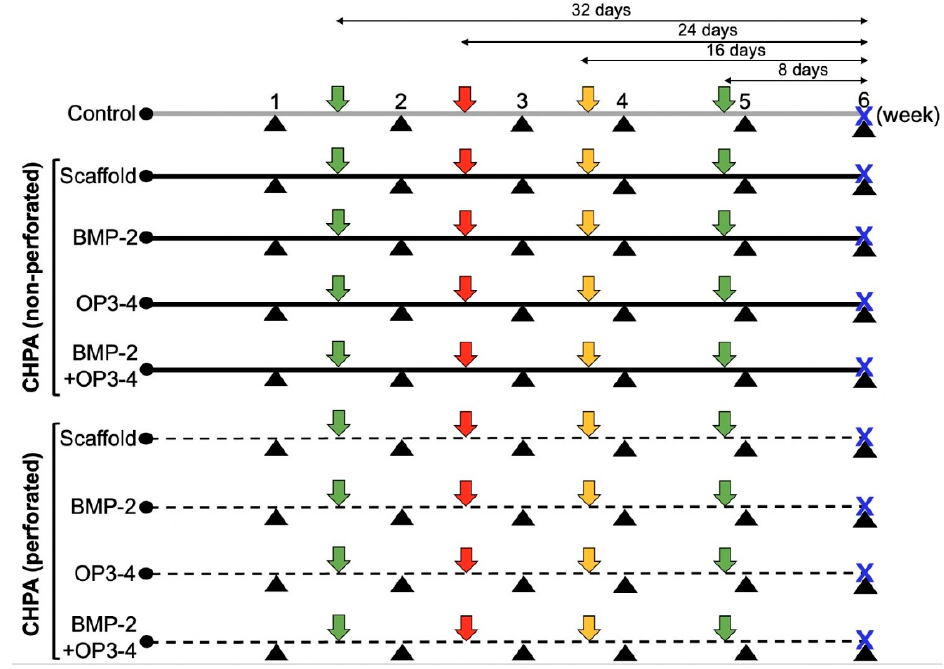
Figure 6. In vivo protocol. Black triangle: in vivo μ CT every week; green arrow: fluorescence calcein injection 32 and 8 days before euthanization; red arrow: fluorescence alizarin injection 24 days before euthanization; yellow arrow: fluorescence demeclocycline injection 16 days before euthanization; blue X: euthanization day. Ctr: control group; CHPA: Scaffold material + Vehicle; CHPA + BMP-2: Scaffold material + BMP-2; CHPA + OP3-4: Scaffold material + OP3-4; CHPA + BMP-2 + OP3-4: Scaffold material + BMP-2 + OP3-4.